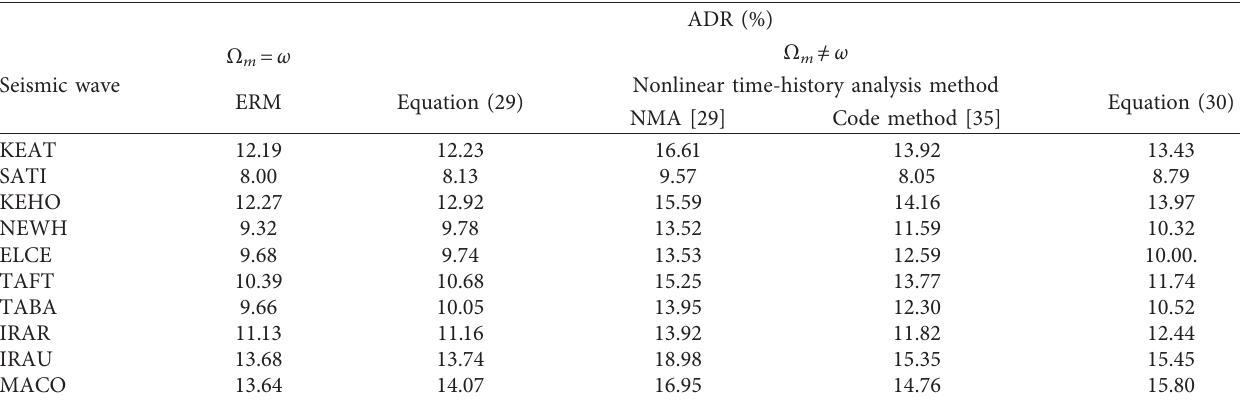
Figure 14: Interstory displacement of the six-story shear frame equipped with linear VFDs. Table 3: ADRs calculated using different